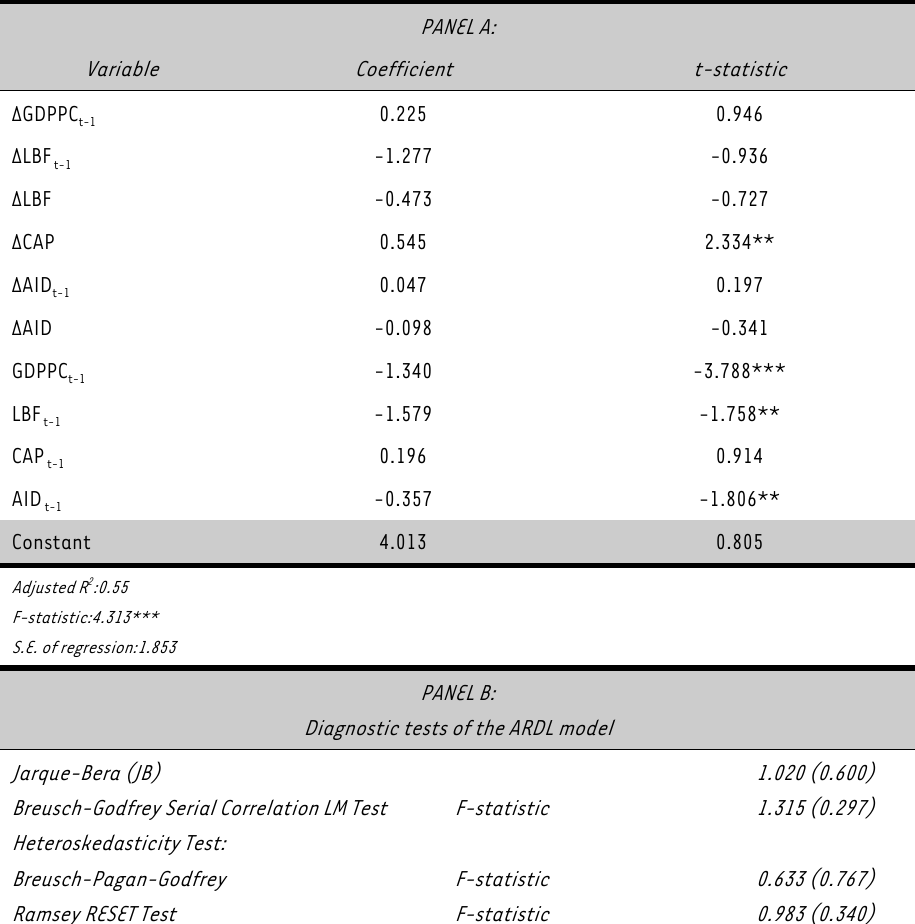
TABLE 2: Estimated ARDL model for per capita GDP growth function